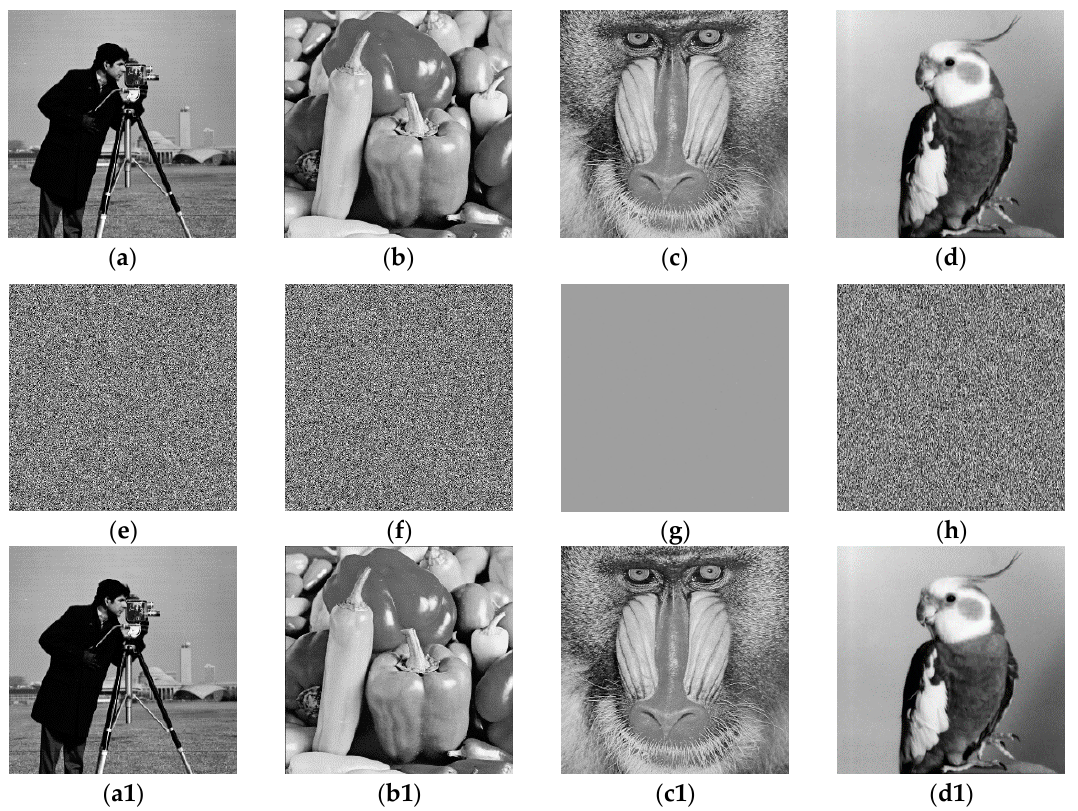
Figure 5. Encryption and decryption results: ( a – d ) original images, ( e ) private key for the first image P 1 , ( f ) combined image f , ( g ) ciphertext C , ( h ) private key PK , ( a1 – d1 ) decrypted images.